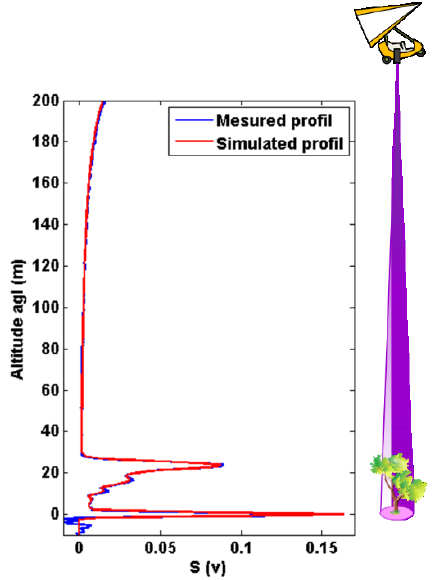
Figure 6. Simulated lidar signal ( Red ) superposed on measured lidar signal ( Blue ) as an example in temperate deciduous forests in winter. Lidar signal S is in